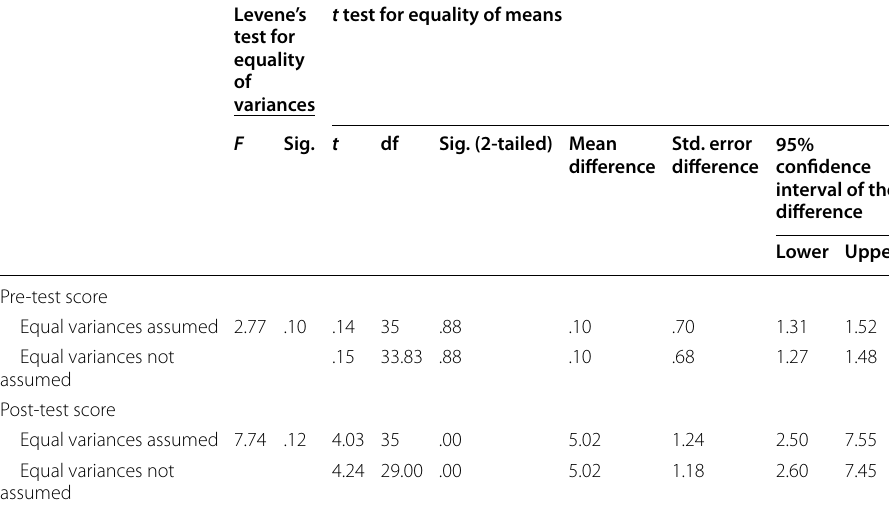
group counterparts ( M 11.50 for the experimental subjects with a 4.65 standard devia- = tion and M 6.47 for the control group with a 2.34 standard deviation). = Table 3 indicates that the homogeneity assumption underlying the independent sam- ples t test is assumed as the sig. value both before and after the instruction is above 0.05 ( p > 0.05).